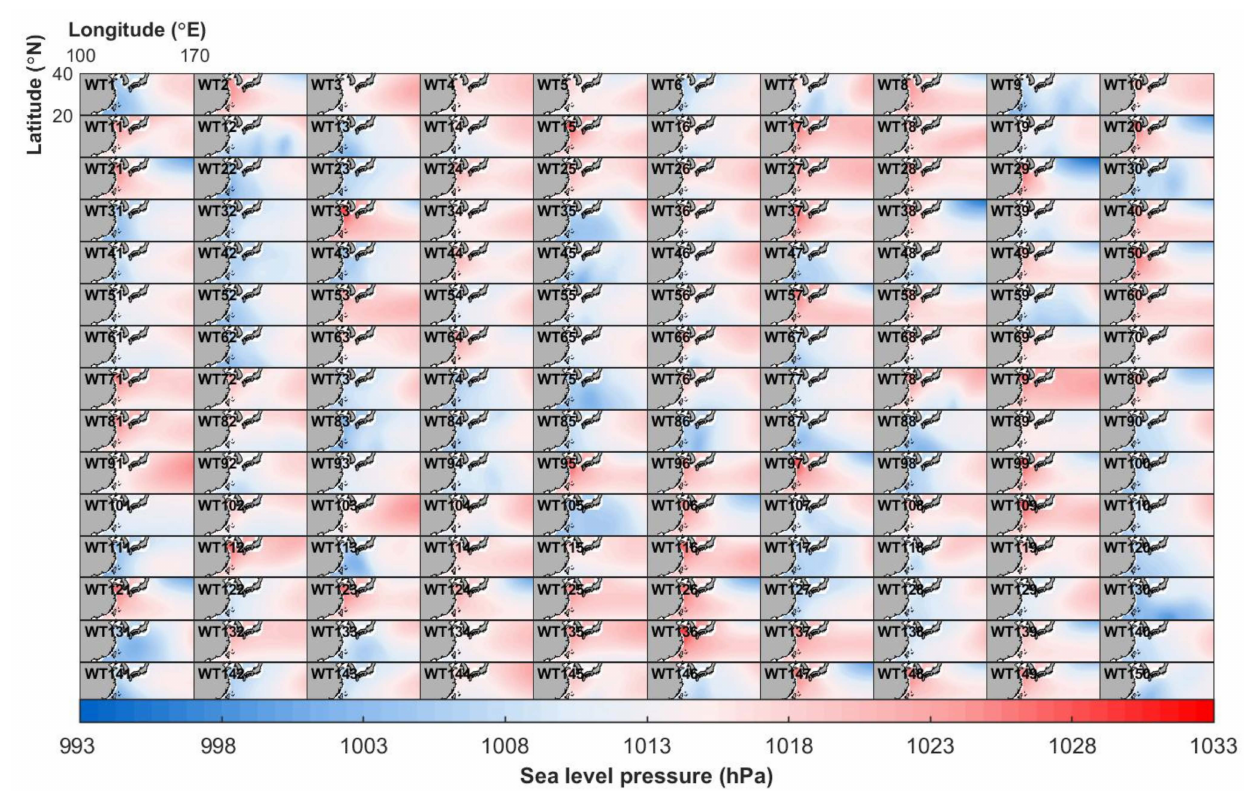
Figure 5. A total of 150 weather types obtained from SLP fields (hPa) using atmospheric classification.